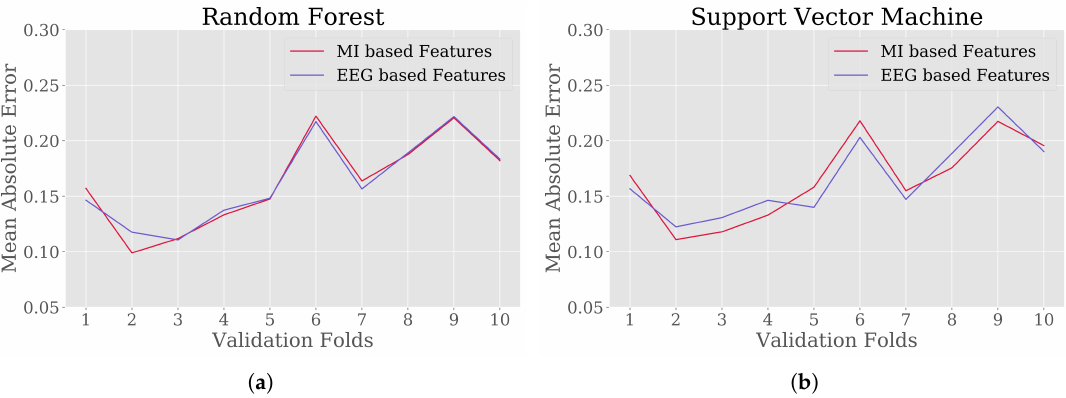
Figure 7. The 10-fold CV score in terms of MAE for regression models: ( a ) Random Forest (RF) and ( b ) Support Vector Machine (SVM), where the expert derived MWL scores were considered as true values. For each of the models, two different sets of features were used (Table